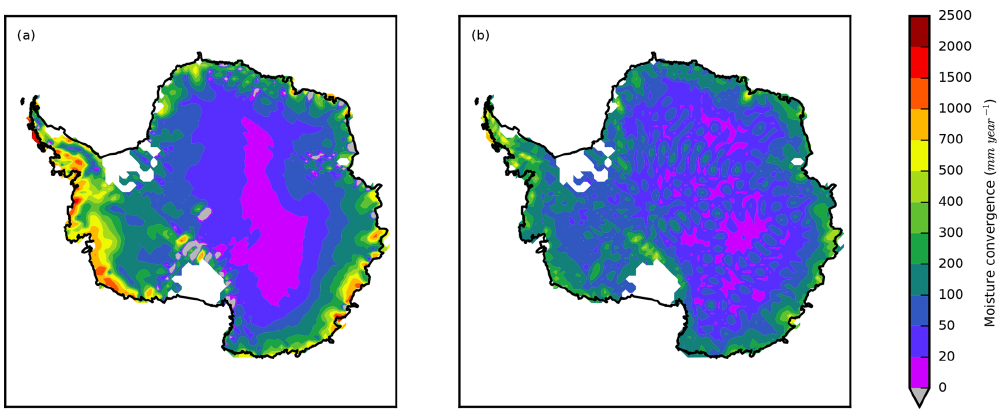
Figure 3. Mean vertically integrated moisture flux convergence over Antarctica in ERA-Interim (a) and the standard deviation of that variable for all the studied reanalyses (b)